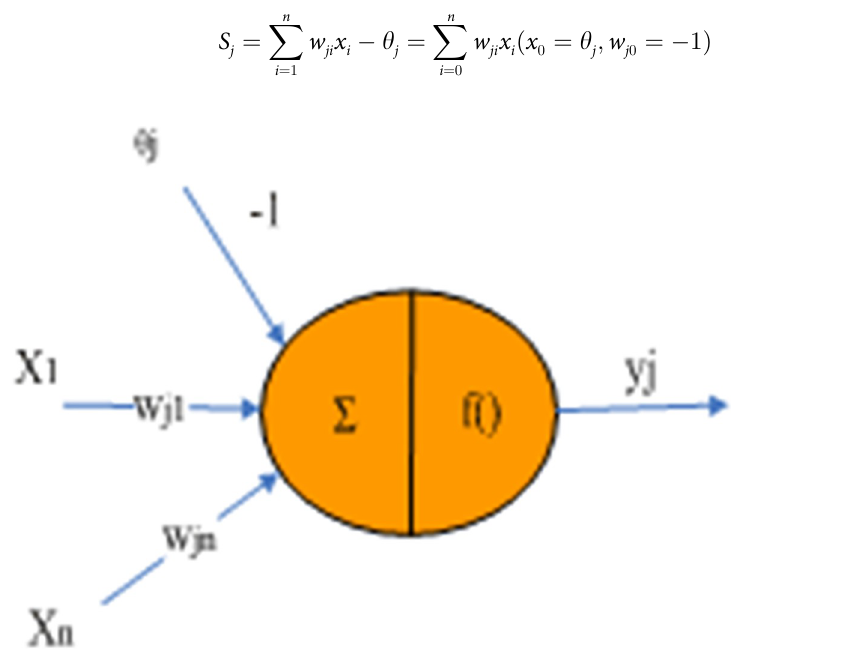
Fig 3. Artificial neuron